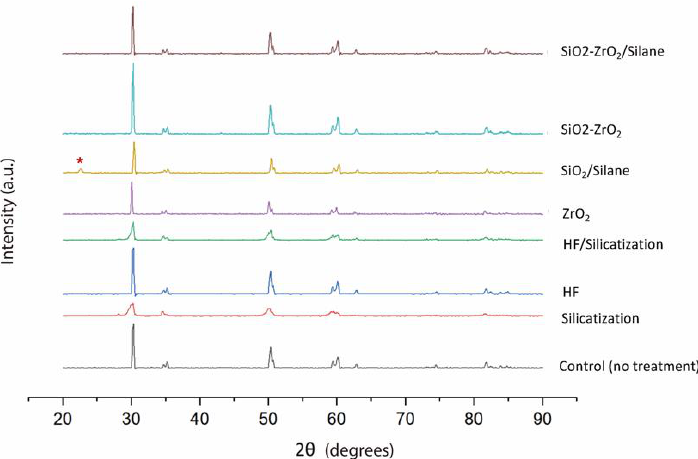
Different uppercase letters (in the column) represent significant differences ( p -value < 0.05).